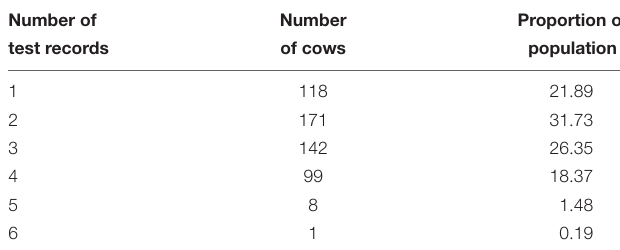
TABLE 1 | Distribution of the number of test records available for analysis. Number of